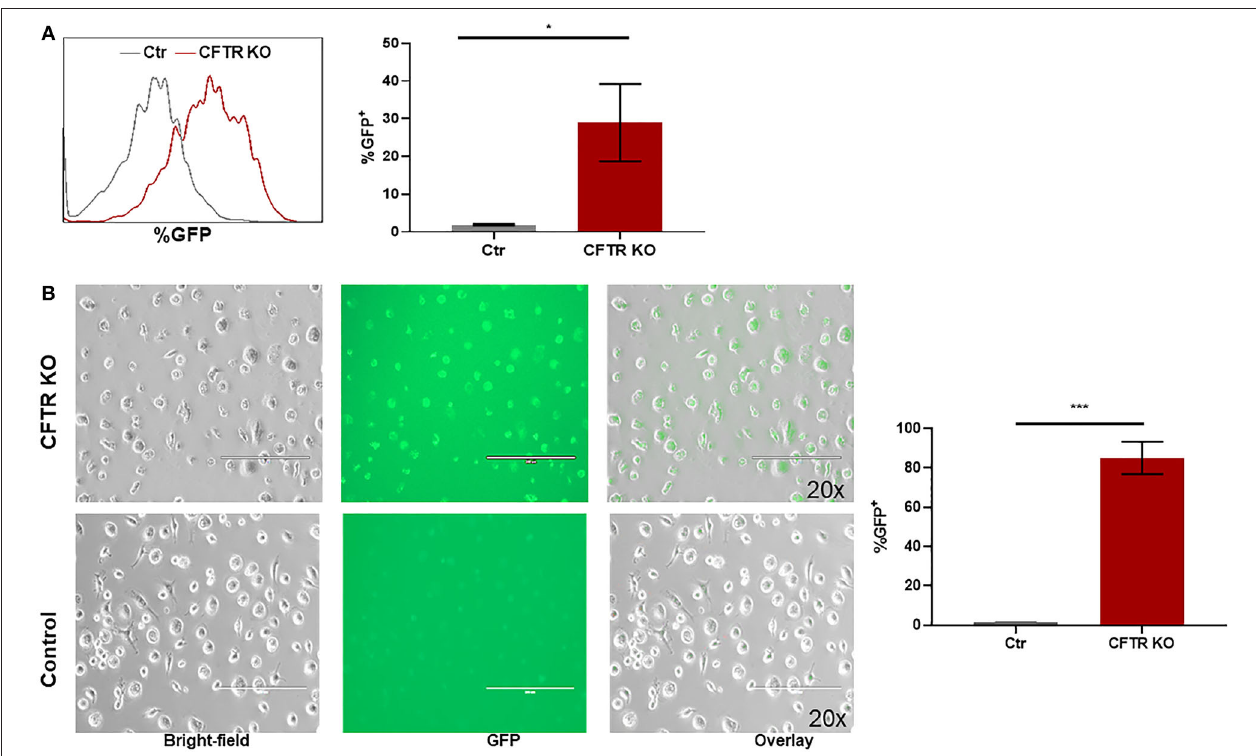
FIGURE 1 | Setup of CFTR KO model. (A) Representative flow cytometry histogram and corresponding summary of GFP detection of CFTR KO MDMs prior to puromycin selection. * p < 0.05 via unpaired t -test, n = 3, mean ± SD. (B) Representative GFP fluorescence images of hMDMs transfected by CFTR Crispr Double Nickase plasmid in DOTAP with corresponding summary of GFP detection, n = 3. (Top) 48h selection by puromycin. (Bottom) hMDMs in DOTAP only as control. 200 µ m scale bar. Bright-field, GFP + , and overlay images shown in left to right order. *** p <